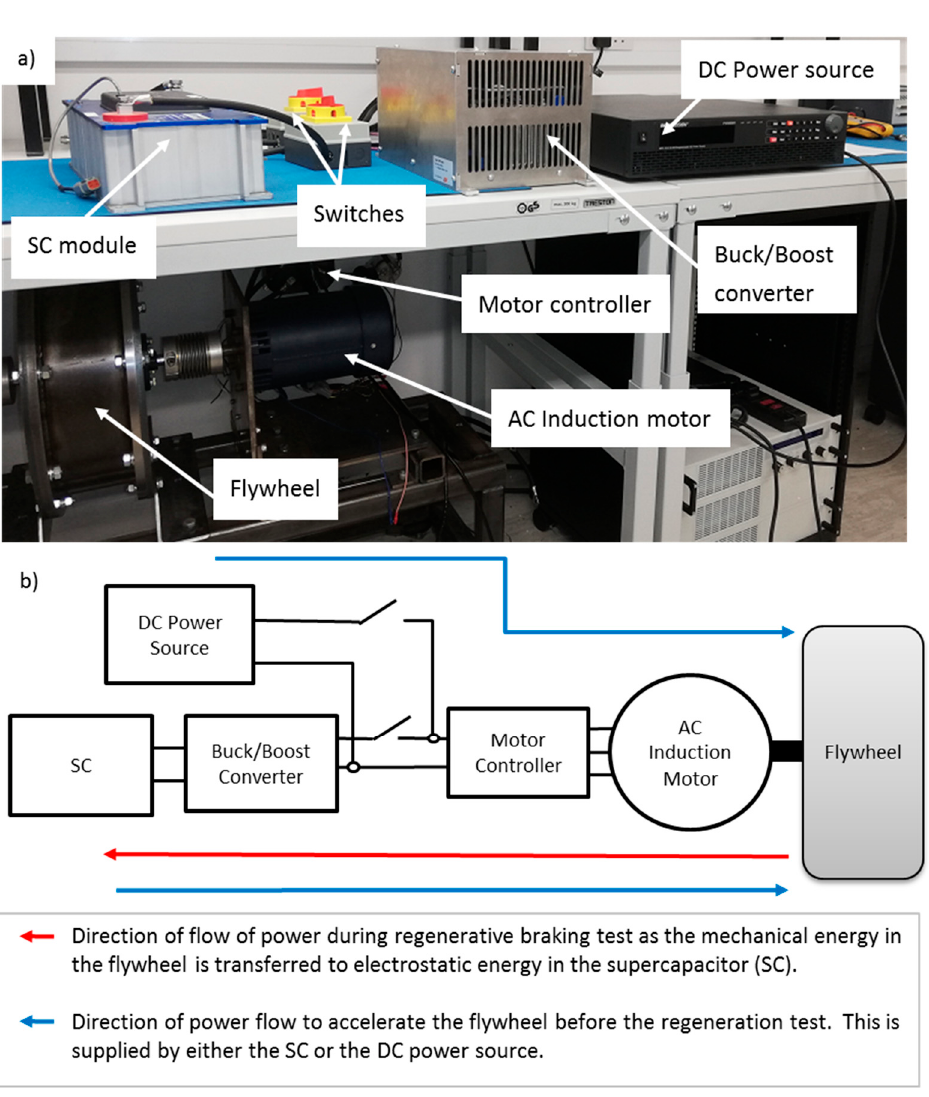
Figure 3. ( a ) Picture of the laboratory test rig; ( b ) schematic of the laboratory test